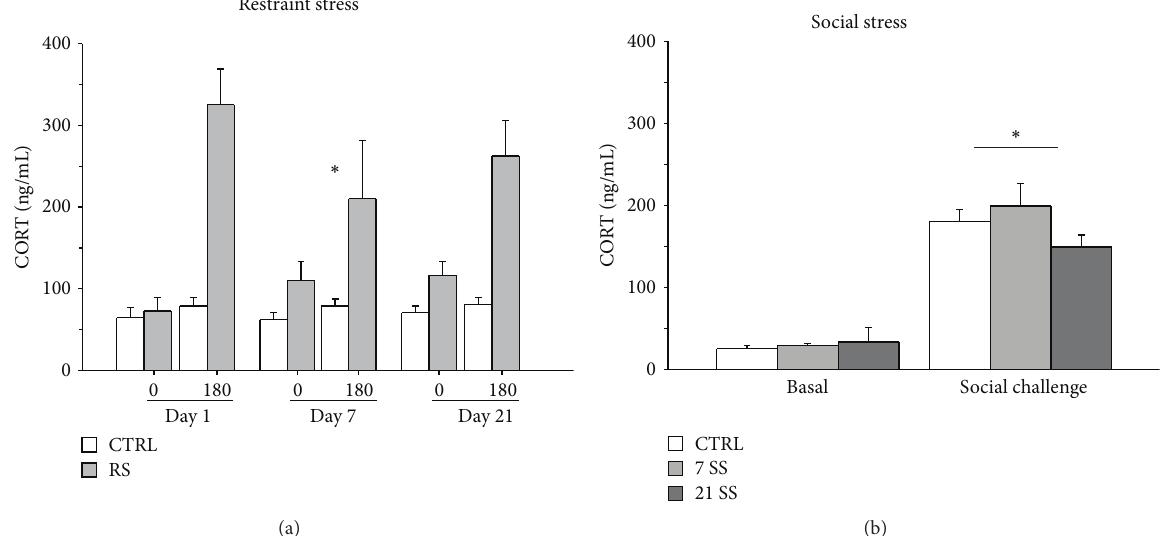
Figure 1: Effect of restraint stress on CORT secretion in mice. All subjects undergoing RS showed a reduced response of the HPA axis on day 7 (a). Effect of social stress on CORT secretion in mice. The response to an acute challenge (represented by the Social Interaction Test) was effective in inducing an increase in CORT secretion in all groups, with no differences in relation to social stress exposure (b). Results are presented as mean + S.E.M. ∗ 𝑃 < 0.05 .